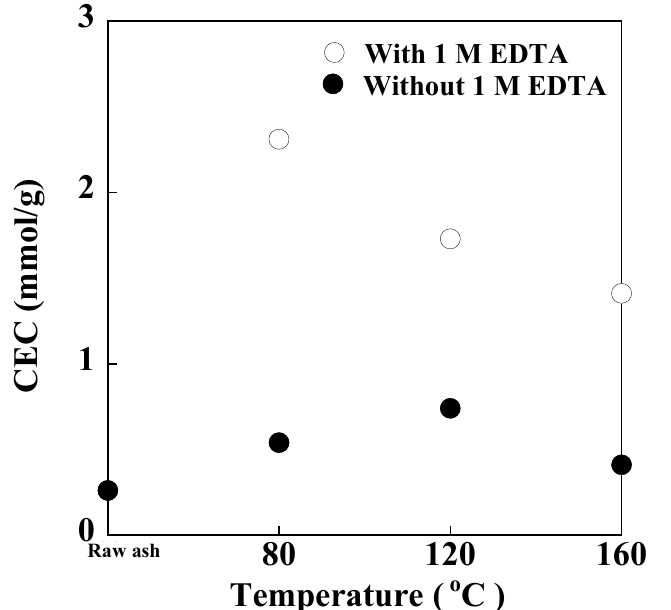
Figure 6. CECs of PSA and the products synthesized from PSA with and without 1 M EDTA at various temperatures (NaOH concentration: 3 M NaOH, Reaction time: 24 h).